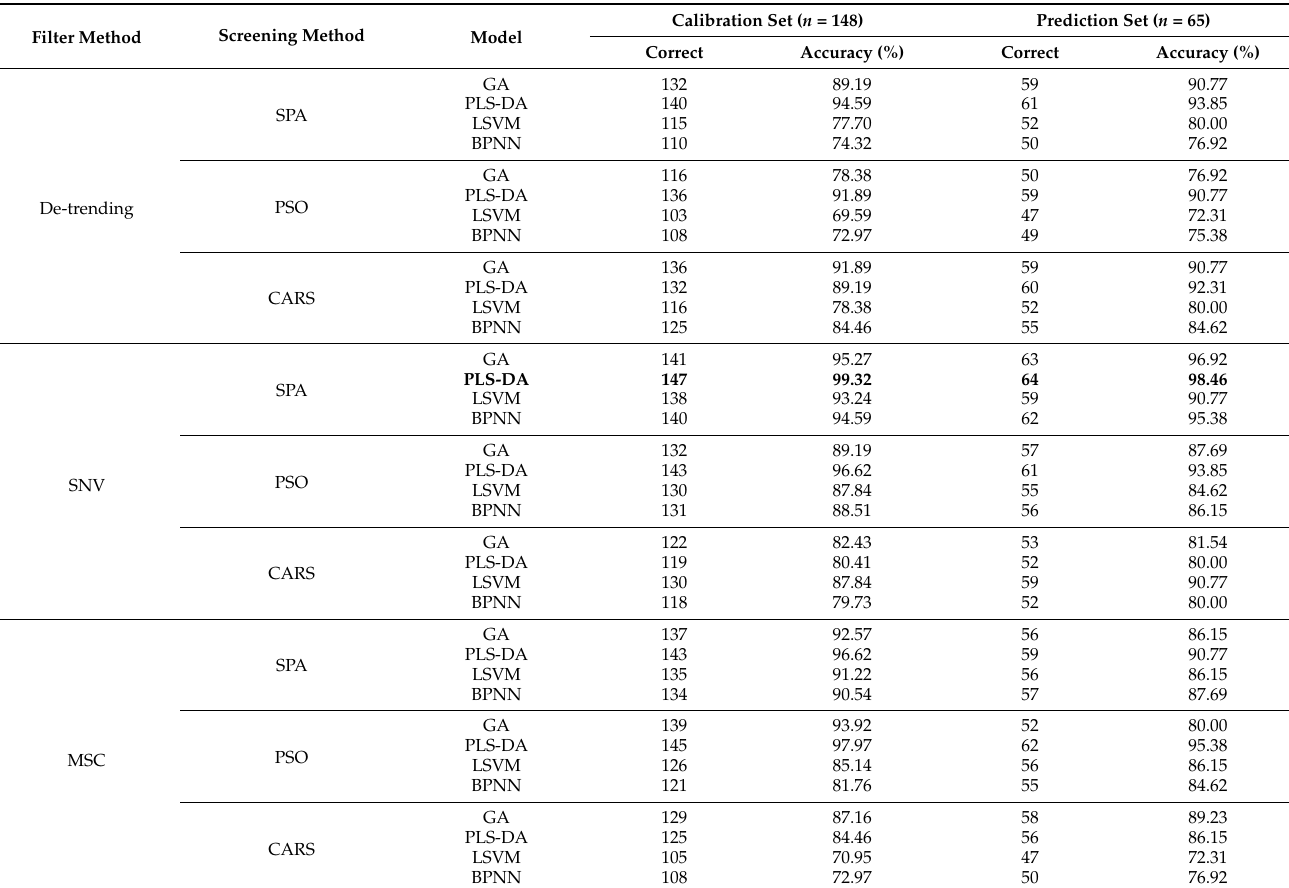
Table 4. The results of GA, PLS-DA, LSVM, and BP classi fi cation based on characteristic wave- lengths.